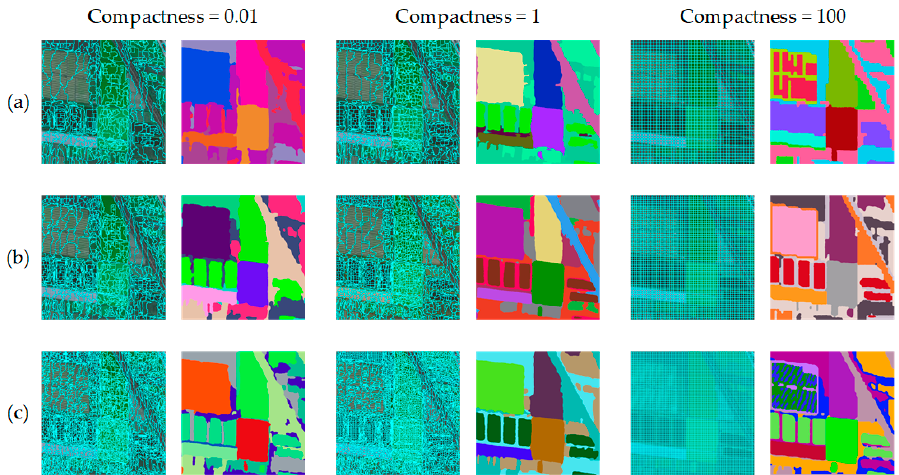
Figure 9. Representative examples of image segmentation results on Zhejiang dataset, influenced by diverse settings of our image filter: ( a ) superpixel number equals K/2, ( b ) superpixel number equals K, ( c ) superpixel number equals 2K. The left image in each group is the superpixel-based over-segmentation map, while the right one is the image segmentation result.